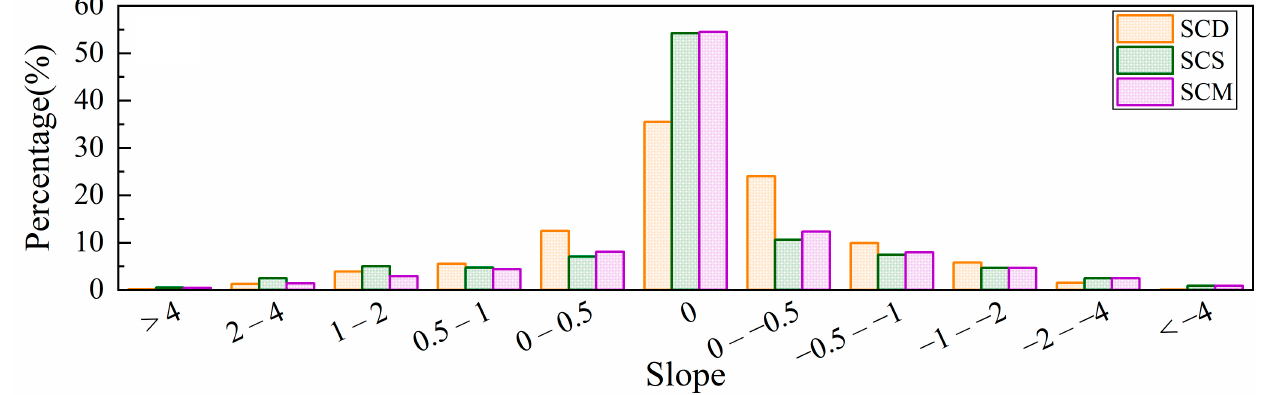
Figure 3. The percentage of different slopes for snow cover days (SCD), start (SCS), and melt (SCM) in China.